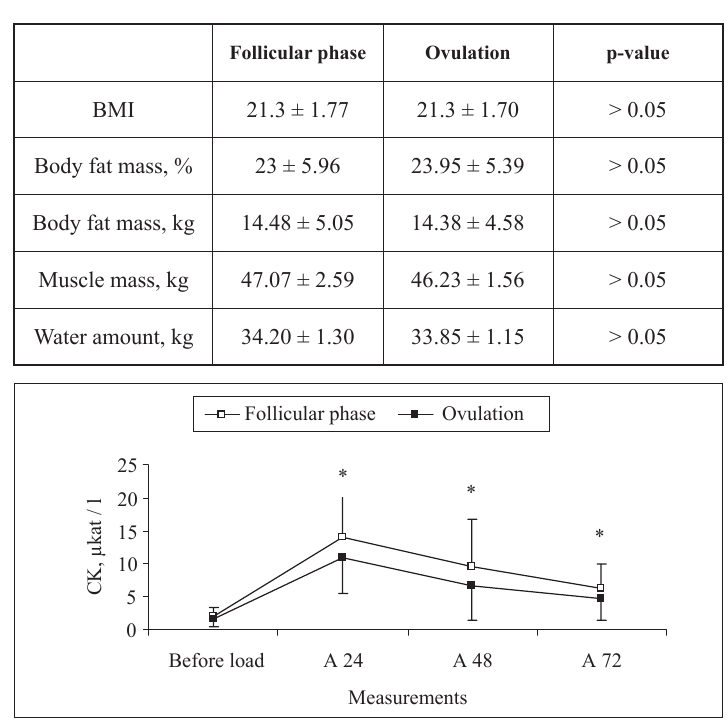
Figure 4. Concentration amount of creatine kinase (CK) in the ovulation and follicular phase